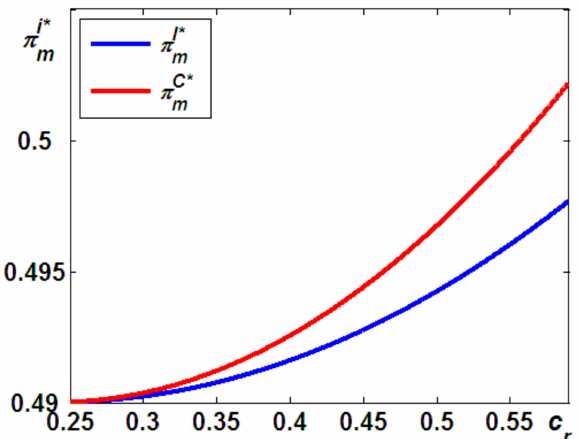
Figure 4. Difference in the OEM’s